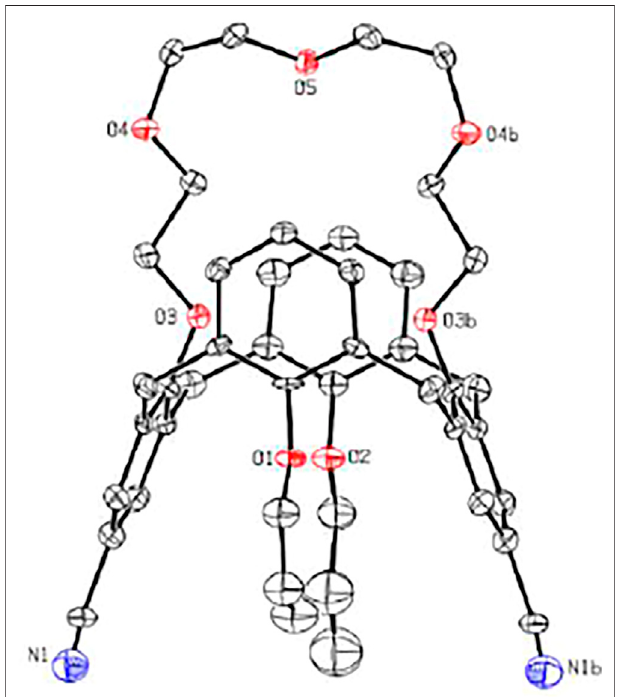
FIGURE 1 | X-ray molecular structure of 5 .